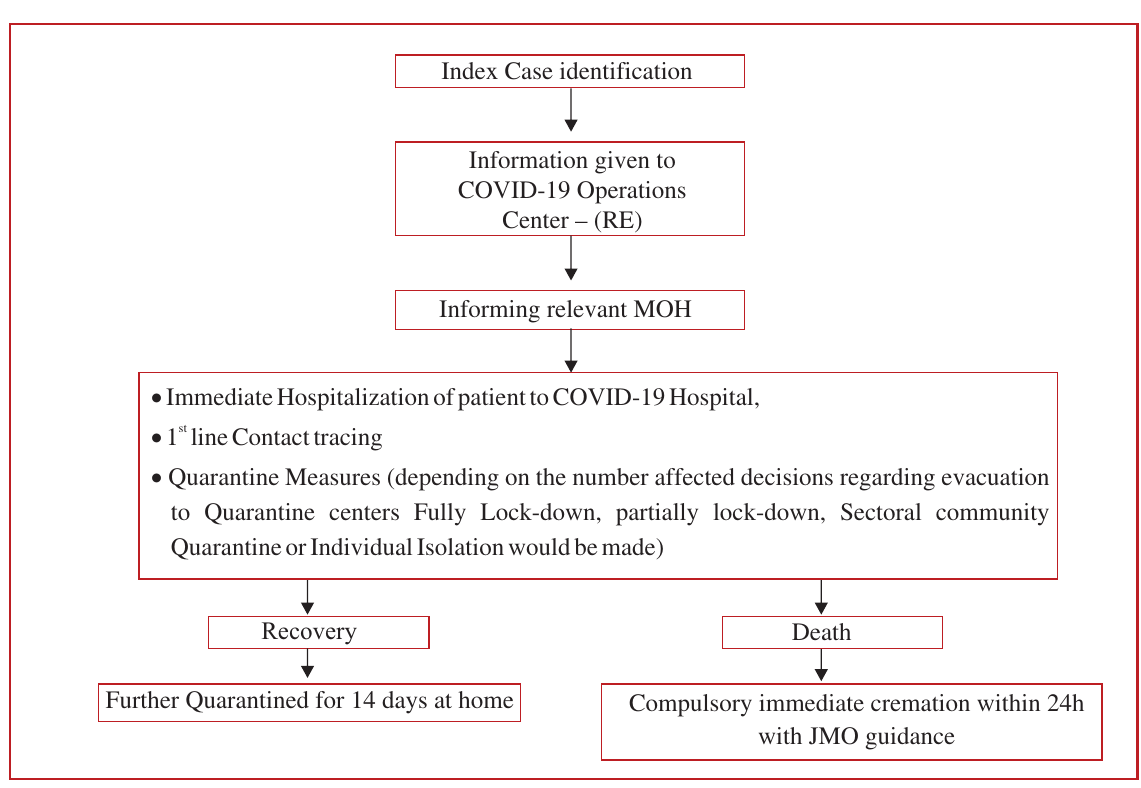
Figure 3: Quarantine measures in the City of Colombo